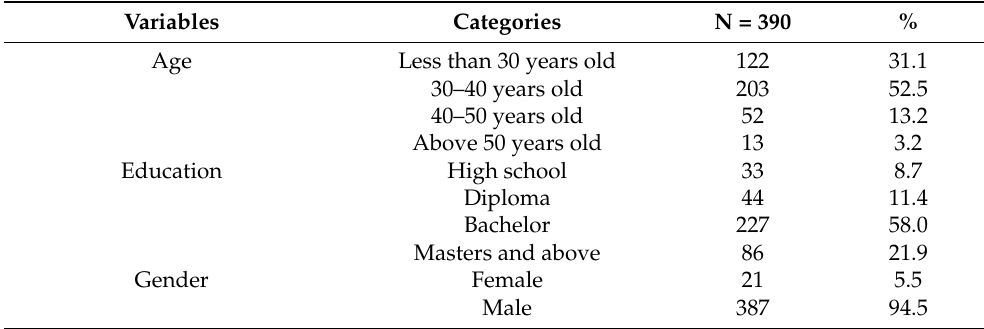
Table 1. Demographic characteristics of the